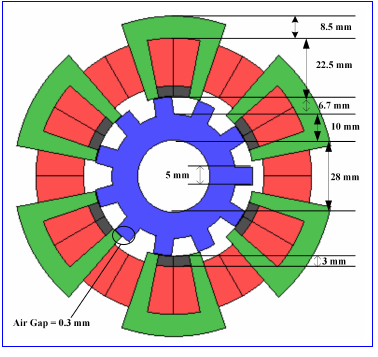
Figure 2. Parameters of the model. Table 1. Design parameters of the proposed modular rotor